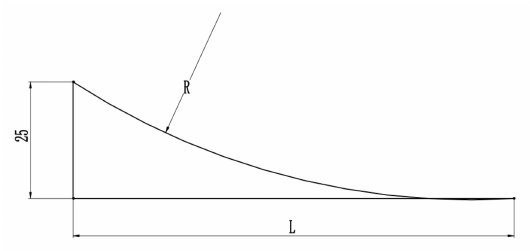
Figure 13. Parameters of transition